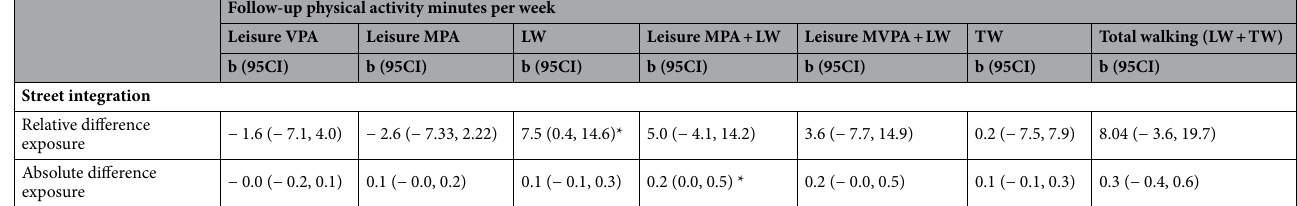
Table 4. Association in follow-up weekly physical activity minutes a in relation to relative difference and absolute difference exposure to street integration among movers only (n = 295). Unstandardized beta (b) coefficients (slope) adjusted for baseline sex, age, children, education, income, and employment status. A positive b reflects a decreasing difference in negative exposure and increasing difference in positive exposure is associated with more physical activity. A negative b reflects a decreasing difference in negative exposure and increasing difference in positive exposure is associated with less physical activity. Relative difference exposure = [Street integration (follow-up) – street integration (baseline)] / street integration (baseline). Absolute difference exposure = [Street integration (follow-up) – street integration (baseline)]. MPA: moderate- intensity physical activity. VPA: vigorous-intensity physical activity. MVPA: moderate-to-vigorous intensity physical LW: leisure walking. TW: transportation walking. *Statistically significant (p < .05) association between street integration exposure and follow-up physical activity. a The follow-up physical activity variables are unstandardized residuals estimated from a linear regression adjusting for baseline physical activity and elapsed time between completed baseline and follow-up